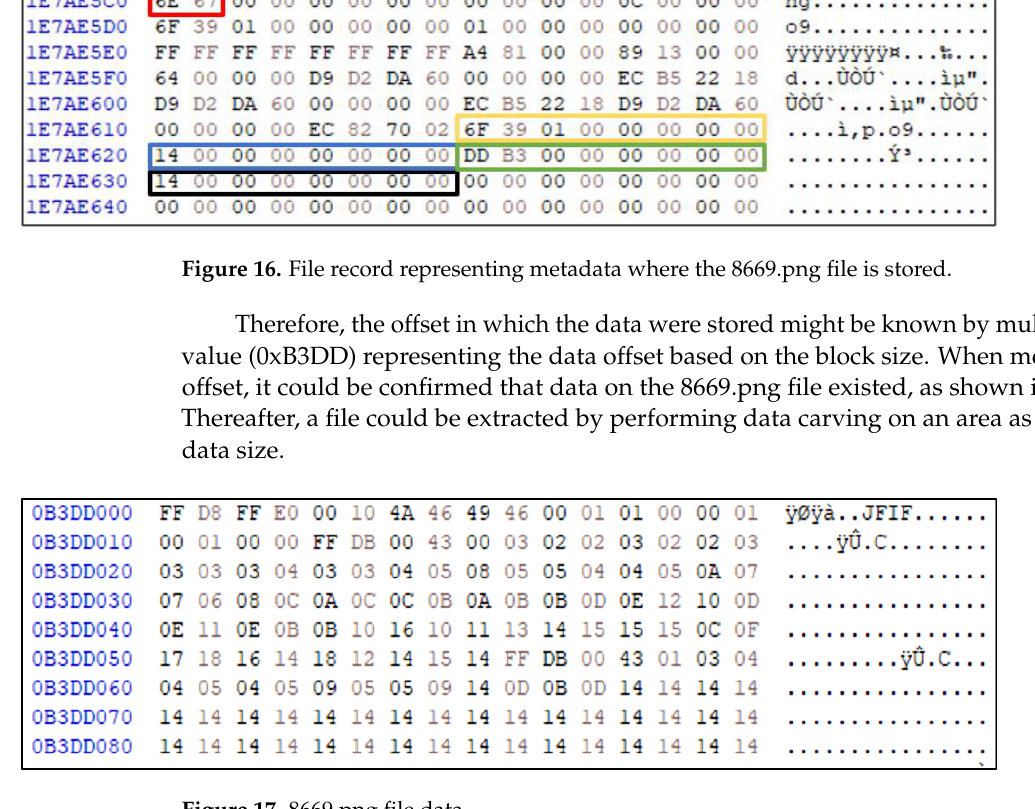
Figure 17. 8669.png file data.